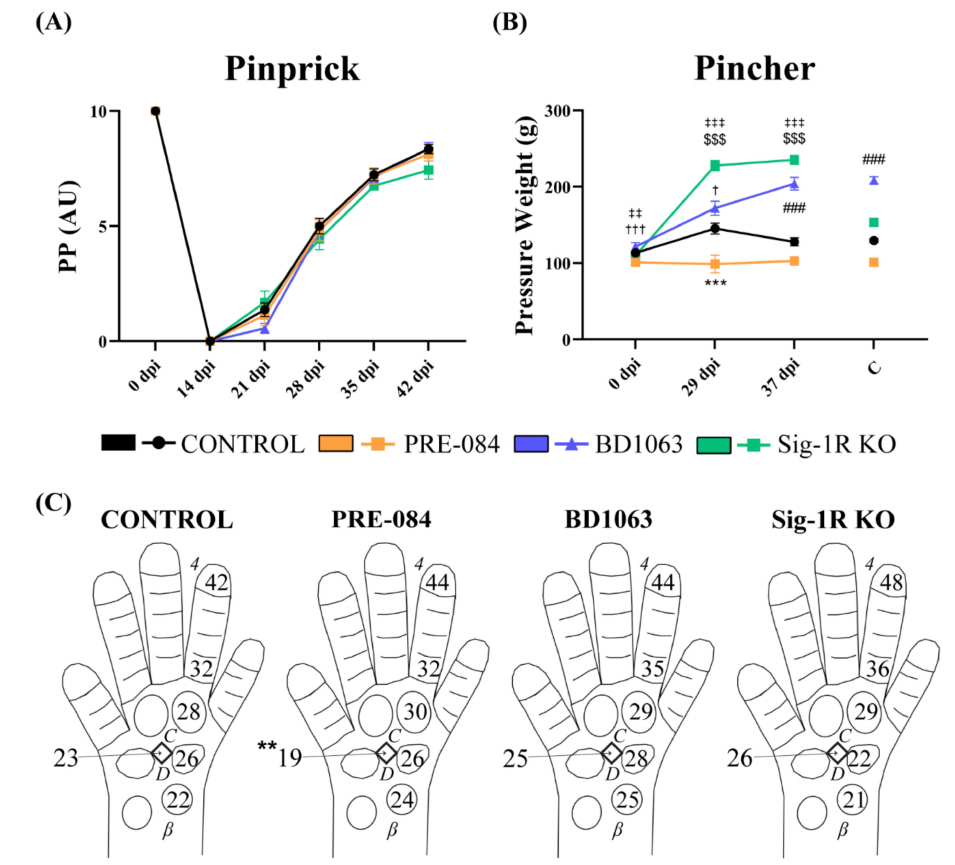
Figure 4. Nociceptive recovery. ( A ) Graph of the PP score during the follow-up; ( B ) Plot of the mean pressure weight, calculated in g, needed to evoke a withdrawal response with the Pincher